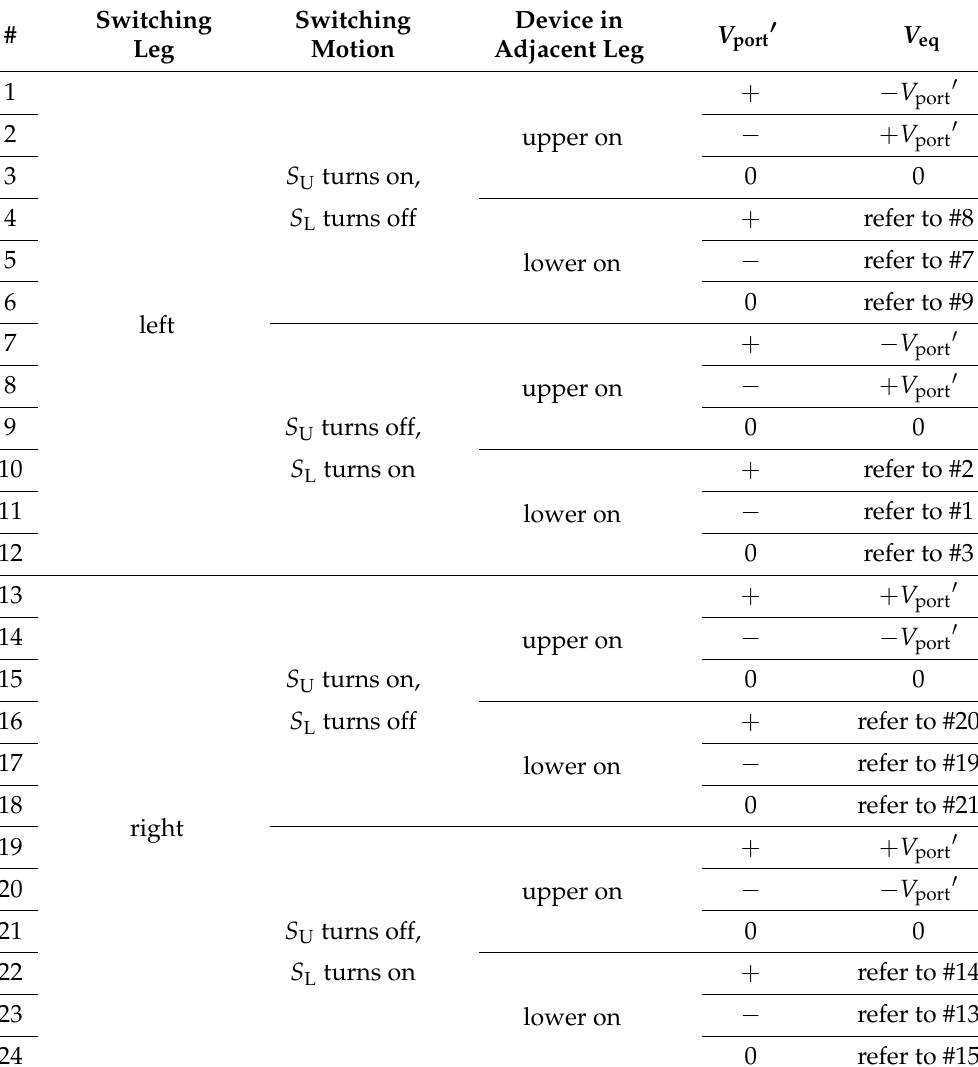
Table 1. List of all possible combinations of switching cases and the corresponding results of V eq in phase-shift